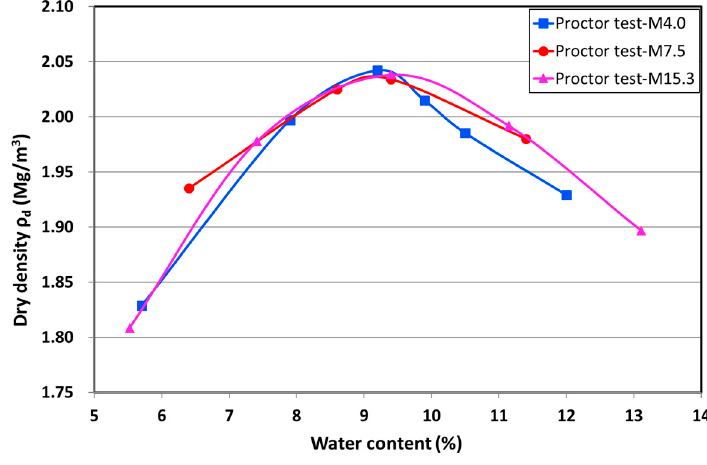
Figure 2. Standard Proctor compaction (M4.0, M7.5, and M15.3).